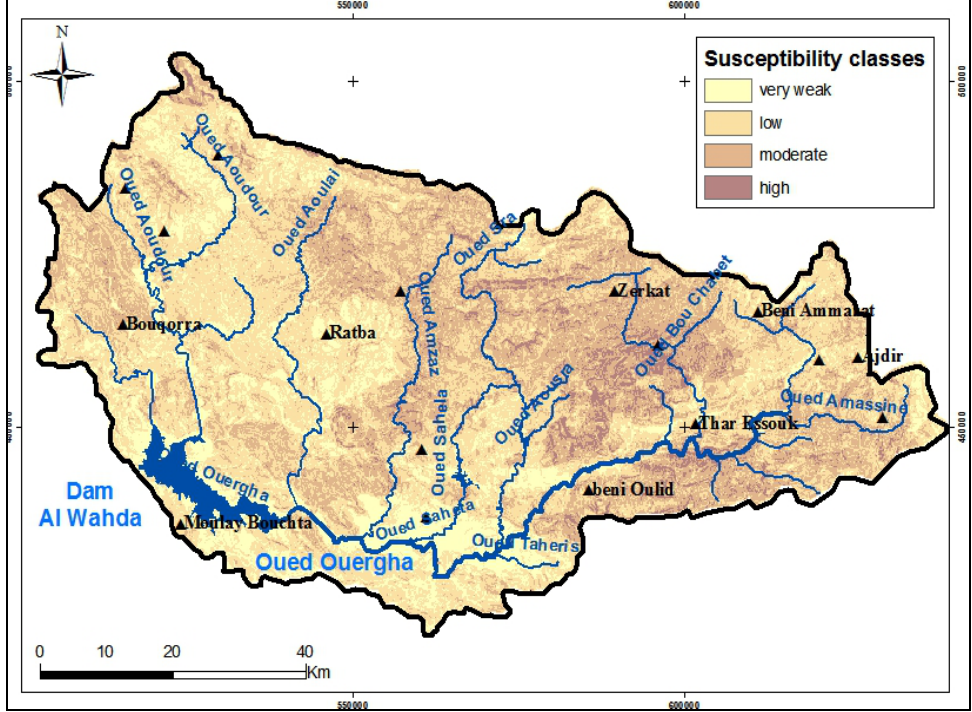
Figure 7 . Soil Susceptibility of the Ouergha